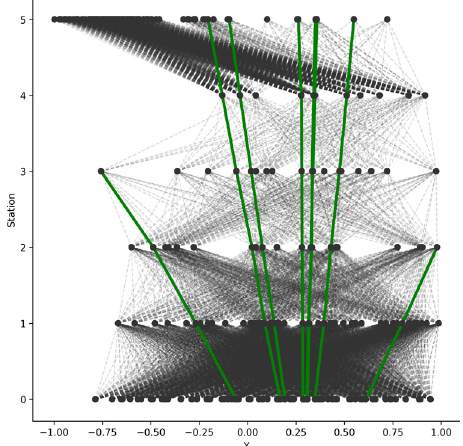
Figure 2. (Color online) Graph of the same event after applying the MBT algorithm. Green bold lines are true segments, dashed gray are fakes. Co- ordinate axes normalized by the detector dimen-